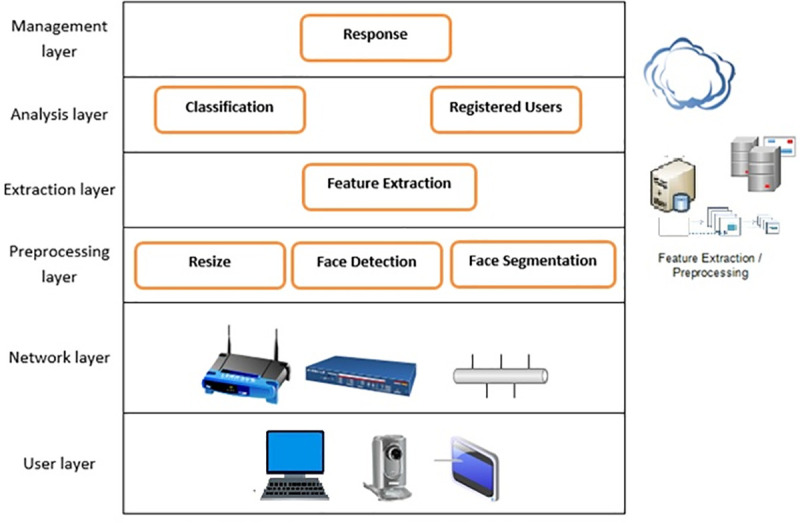
General architecture of the fog computing FR system.